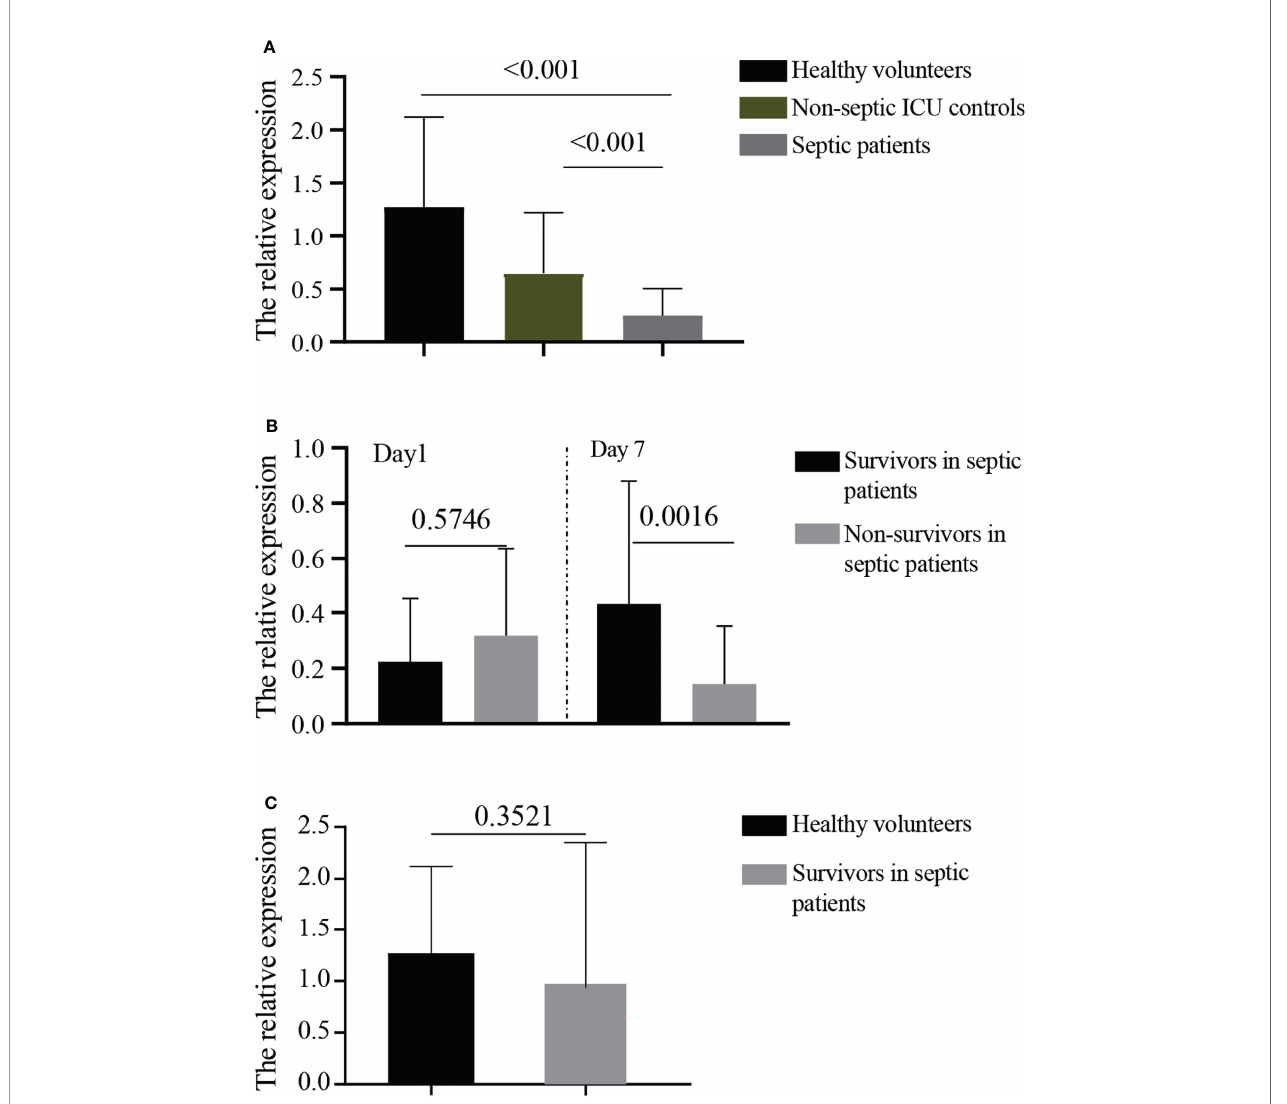
FIGURE 1 | The relative expressions of GPR174 mRNA in patients. (A) The concentrations of serum GPR174 mRNA were measured by quantitative PCR from 101 septic patients, 104 non-septic ICU controls, and 46 healthy volunteers. (B) The concentrations of GPR174 mRNA were measured from survivors and non-survivors in septic patients at Day 1 and Day 7 after ICU admission. (C) The levels of GPR174 mRNA in sepsis survivors at discharge were compared with healthy volunteers. P values less than 0.05 were considered statistically signi fi